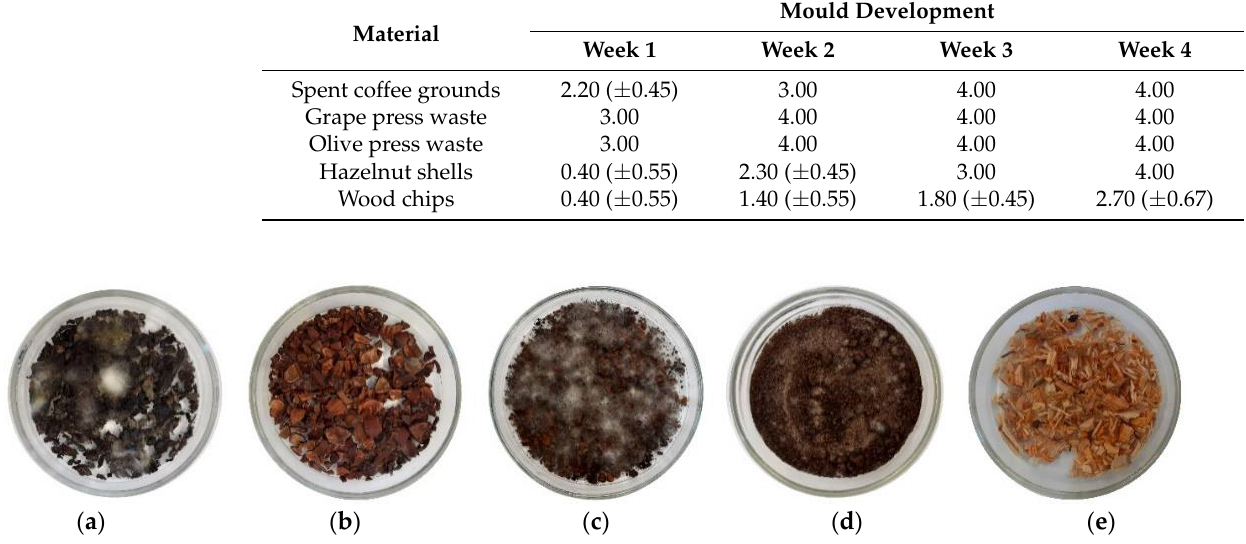
Table 8. Average rate (±standard deviation) of mould growth for the samples without culture media. Material